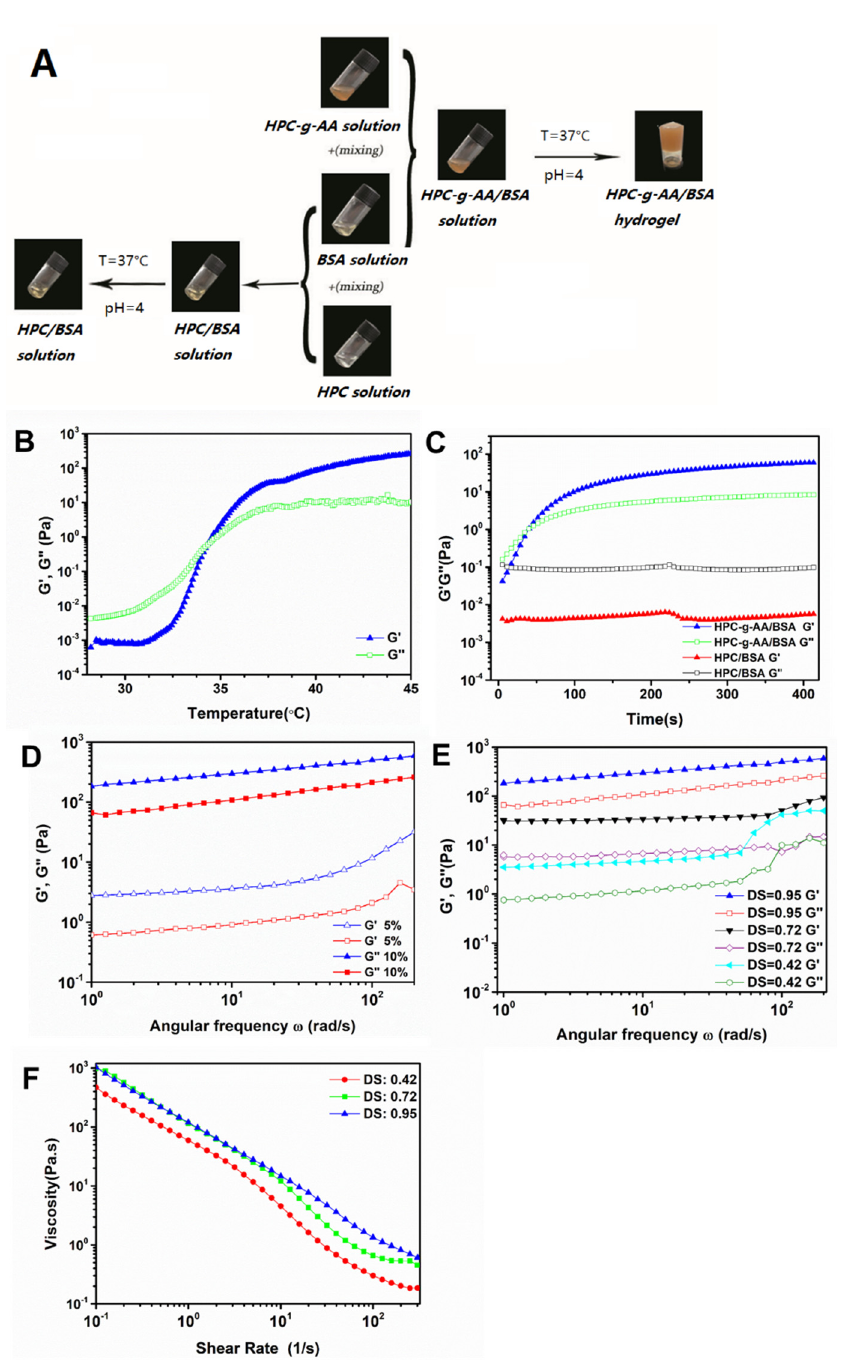
Figure 2. ( A ) Sol-to-gel phase transition photographs of HPC-g-AA/BSA hydrogels at 37 °C; ( B ) temperature sweep of HPC-g-AA/BSA hydrogels; ( C ) temperature sweep of HPC-g-AA/BSA hy- and G (cid:48)(cid:48) modulus of the HPC- g -AA/BSA hydrogel with concentration 5 wt% and 10 wt% from a drogels at 37 °C, a physical mixture of 10 wt% HPC-g-AA and 10% wt% BSA was used as a control; ( D ) G ′ and G ″ modulus of the HPC-g-AA/BSA hydrogel with concentration 5 wt% and 10 wt% from frequency sweep; ( E ) G (cid:48) and G (cid:48)(cid:48) modulus of HPC- g -AA/BSA hydrogels with different DS; ( F ) G (cid:48) a frequency sweep; ( E ) G ′ and G ″ modulus of HPC-g-AA/BSA hydrogels with different DS; ( F ) G ′ and G ″ modulus and viscosity of the HPC-g-AA/BSA hydrogel from a frequency sweep.